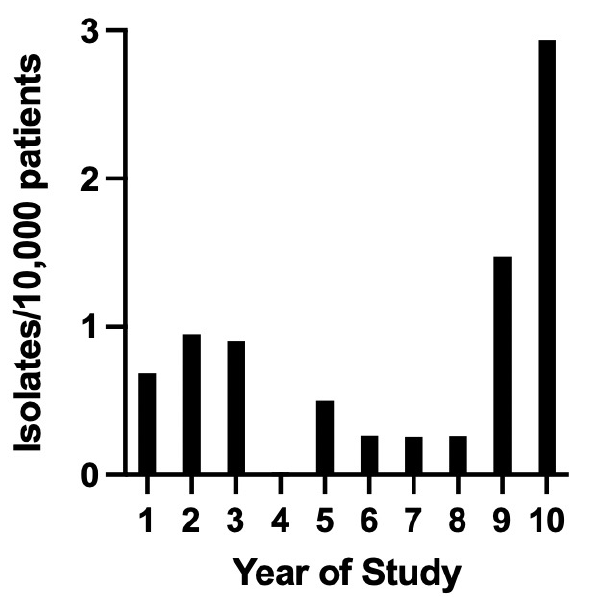
Figure 1. Prevalence of ESBL-producing Enterobacterales (isolates/10,000 patients for each year of the study, year 1 being July 2011–June 2012.